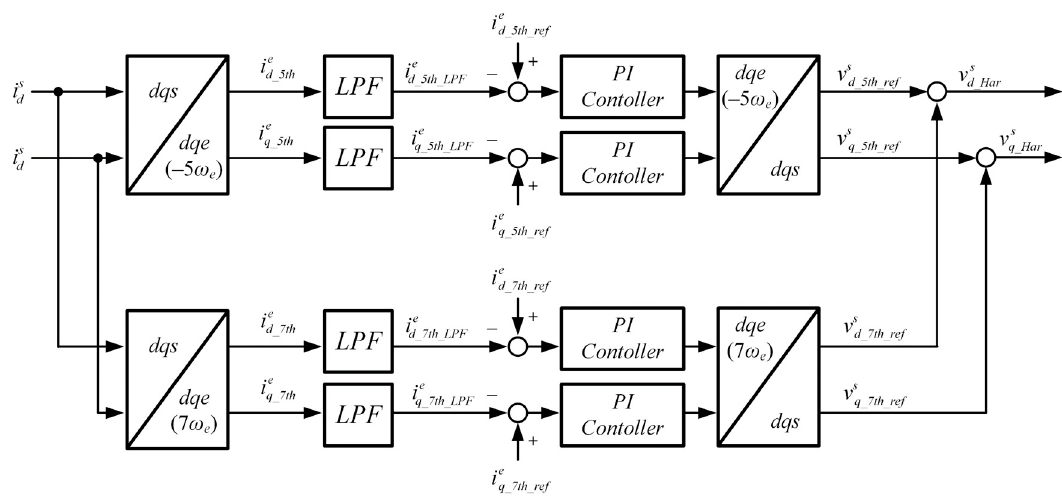
Figure 2. Block diagram of conventional harmonic compensation method. LPF: low pass filter.